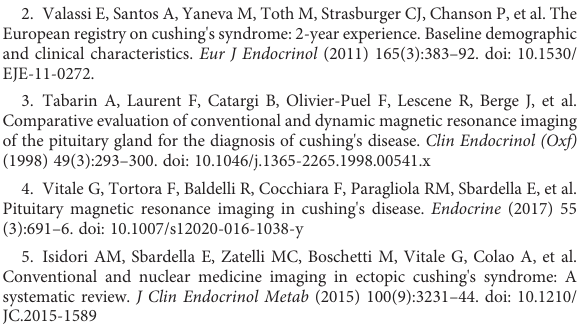
SUPPLEMENTARY TABLE 1 Center-speci fi c number of patients undergoing a CRH stimulation test. SUPPLEMENTARY TABLE 2 Individual outcome of the CRH stimulation test in patients with ectopic Cushing´s